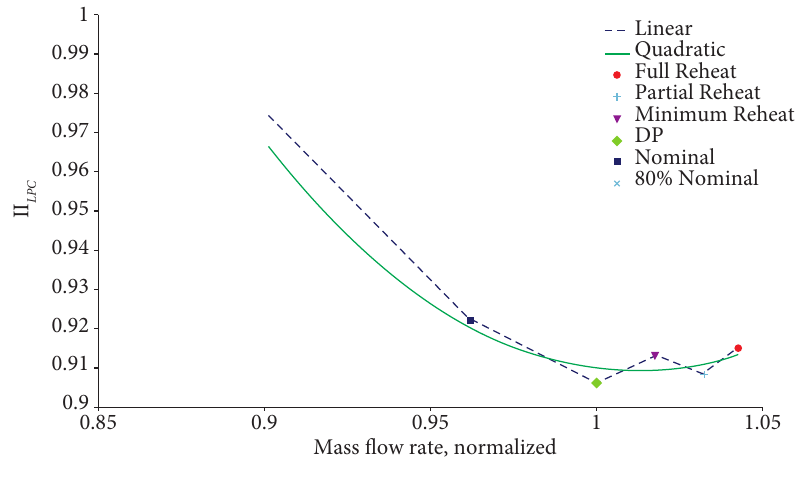
DUCT PRESSURE LOSS FACTOR AND AB